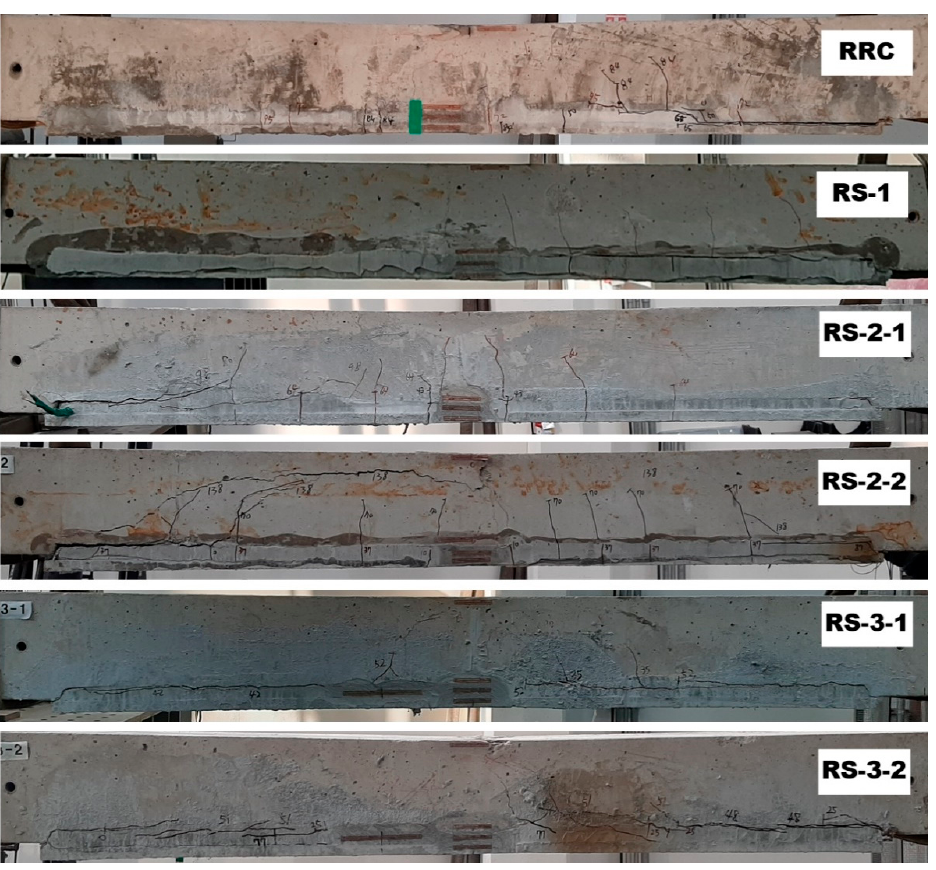
Figure 22. Failure mode of re-strengthening specimens.